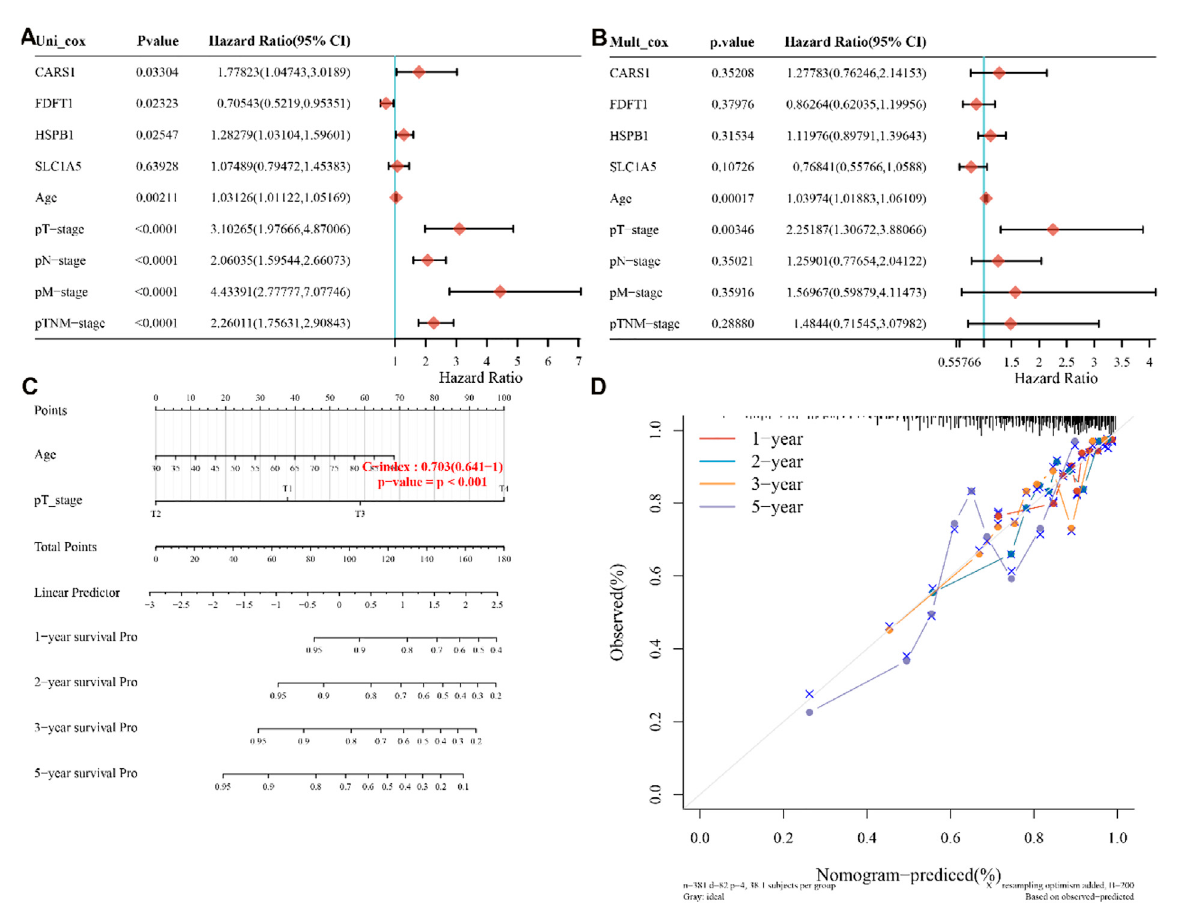
FIGURE 3 four-genes prognostic value and predictive nomogram. (A,B) Multivariate and univariate Cox regression analysis of the four genes is both available, (C) Nomogram developmentbasedon independentprognosticvaluefor the4-genes, (D) Predicting 1 – 5-year survival using anomogram. pT,pN, pM are pathological stages where T is the stage (generally related to the size and depth of the tumor), N is lymph node metastasis, and M is distant metastasis. pTNM stands for Pathological tumor-node-metastasis (pTNM)